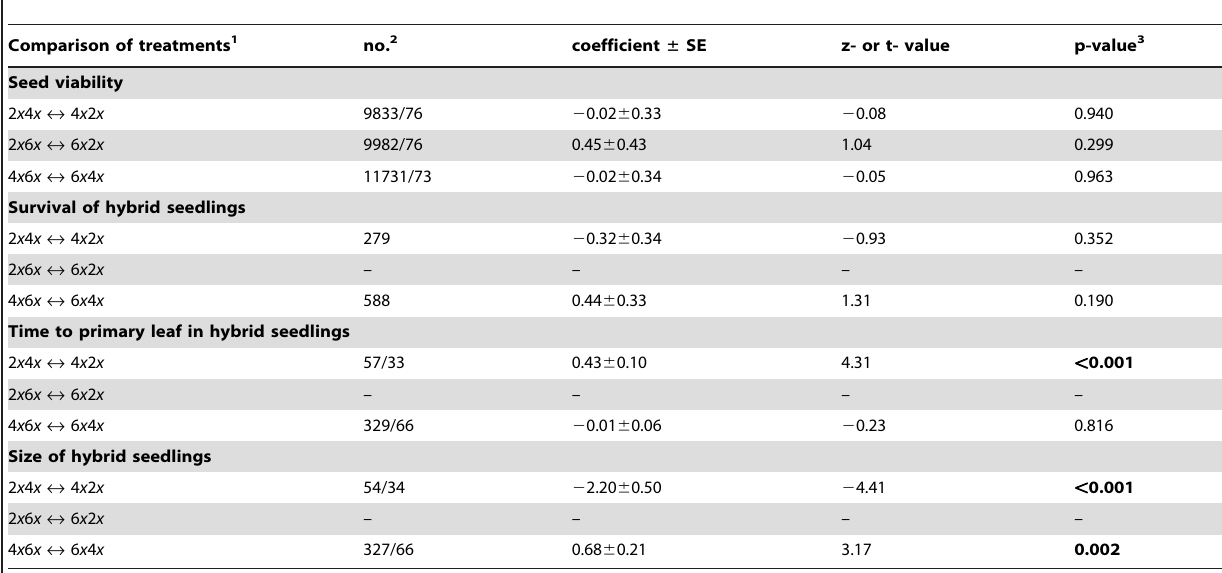
Table 4. Influence of the direction of heteroploid cross-pollinations in Jacobaea carniolica on the fitness of the progeny.